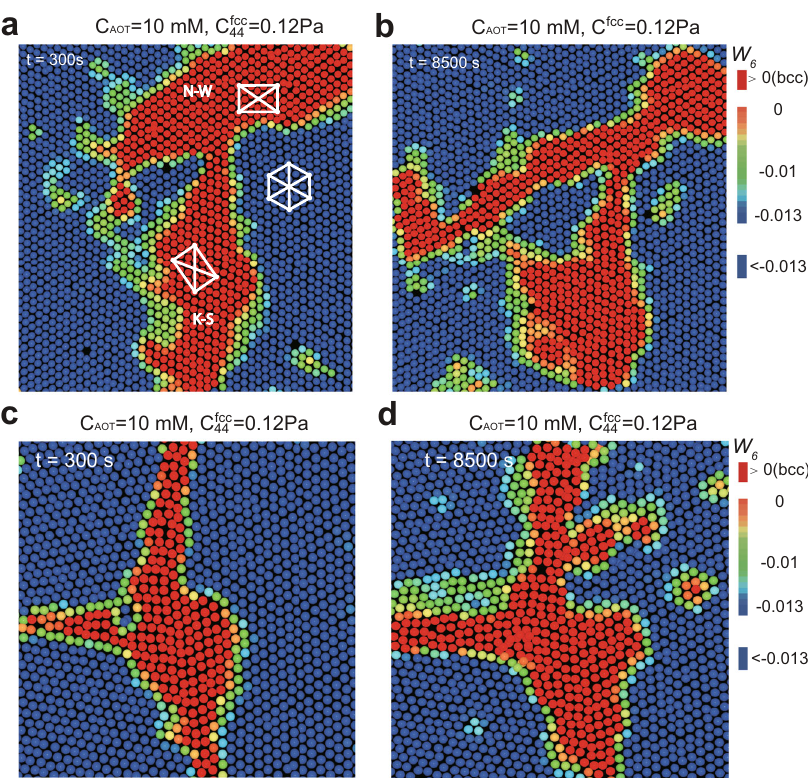
Fig. 5 Pre-existing bcc nuclei inside the fcc grain and at the triple junction of grain boundaries. a Pre-existing bcc nuclei at the parent fcc grain at C aot ~ 60 mM. They already have NW or KS orientation relation with the fcc lattice. b The little development of the bcc nuclei under the weak-driving force ( C aot ~ 10 mM) because of the absence of surface-energy and strain-energy reductions. c Pre-existing bcc nuclei at the triple junction of grain boundaries at C aot ~ 60 mM. d The little development of the bcc nuclei under the weak-driving force ( and strain-energy